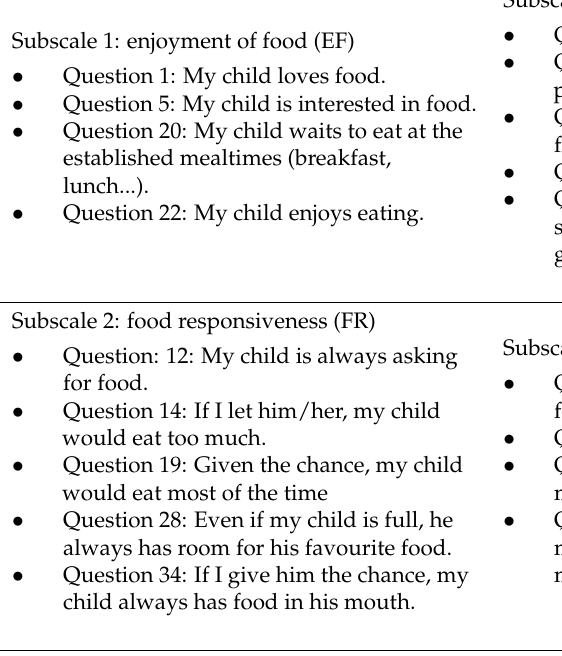
Subscale 1: enjoyment of food